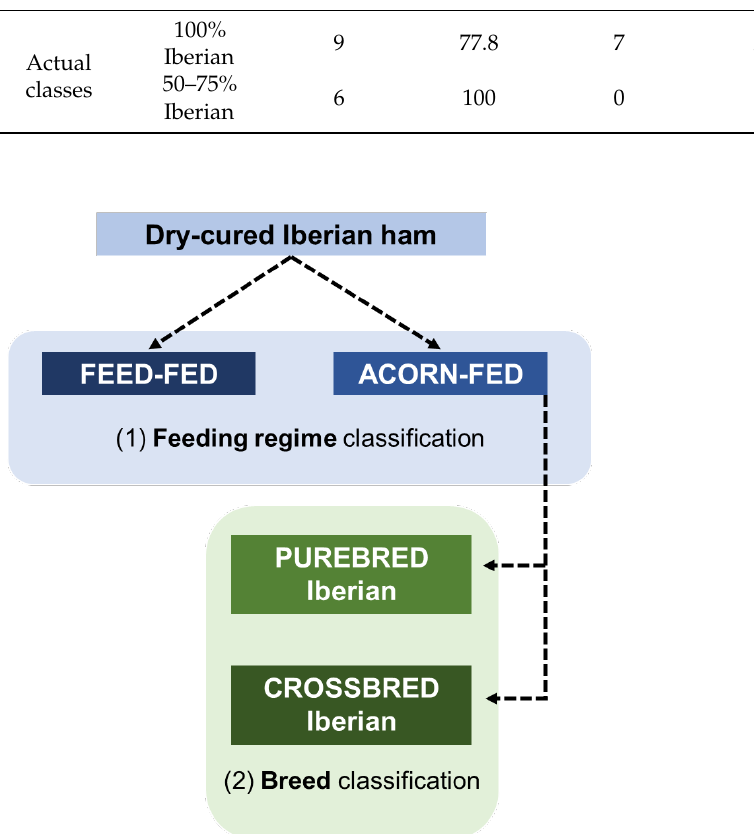
Table 2. Results of breed Raman chemometric classification model with device A. Breed